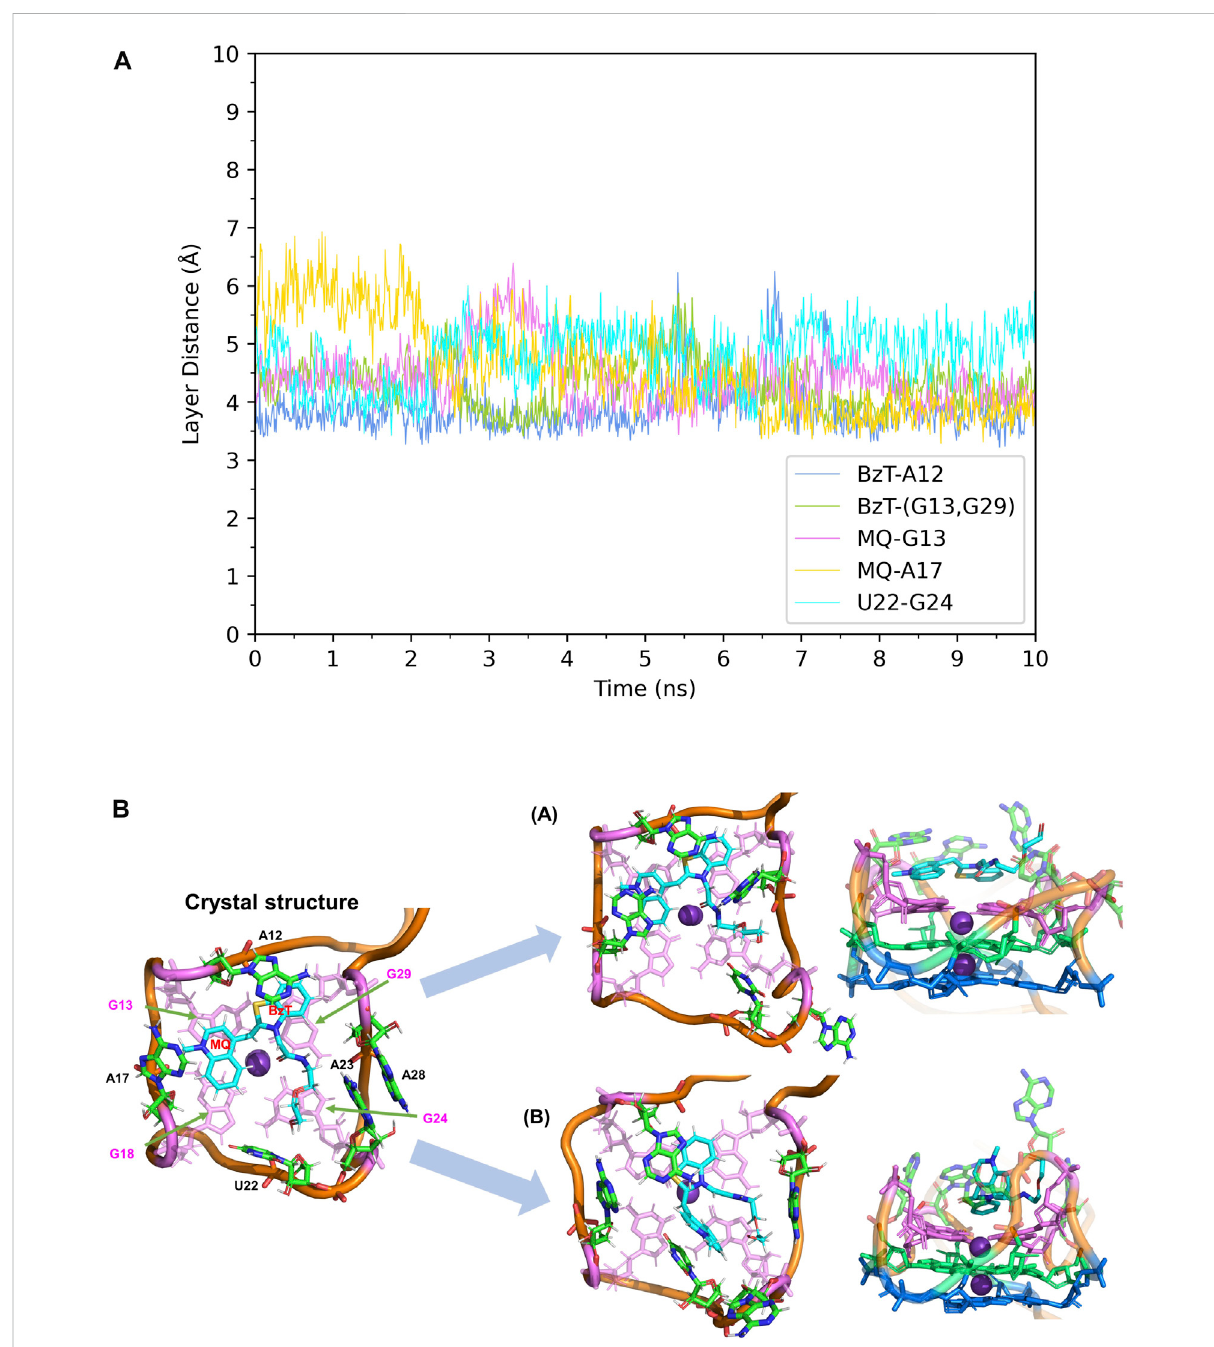
FIGURE 6 Structural analysis of MD simulation on Mango-II mutant (A22U) with TO1-Biotin. (A) : the trajectories of important structural parameters in the MD process to obtain con fi guration A. (B) : the two con fi gurations of the equilibrium structure from the MD process (4 ns snapshot for con fi guration A, 15 ns snapshot for con fi guration B, with the ligand shown in cyan and T3 guanines shown in pink. (Side views have been placed on the right).